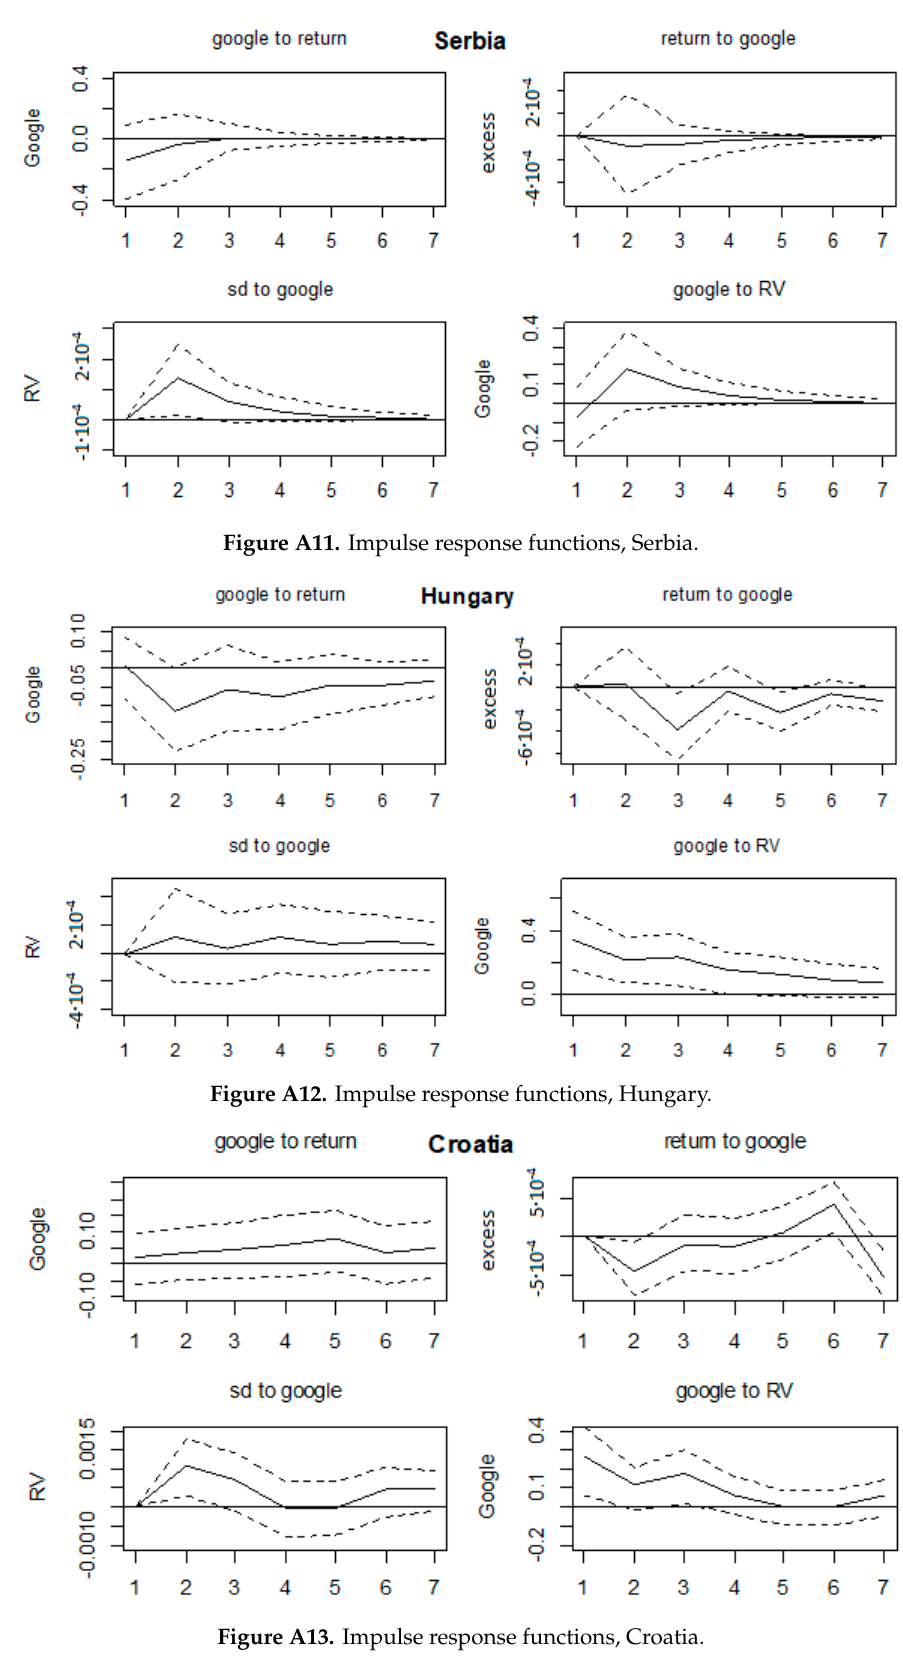
Figure A13. Impulse response functions, Croatia.